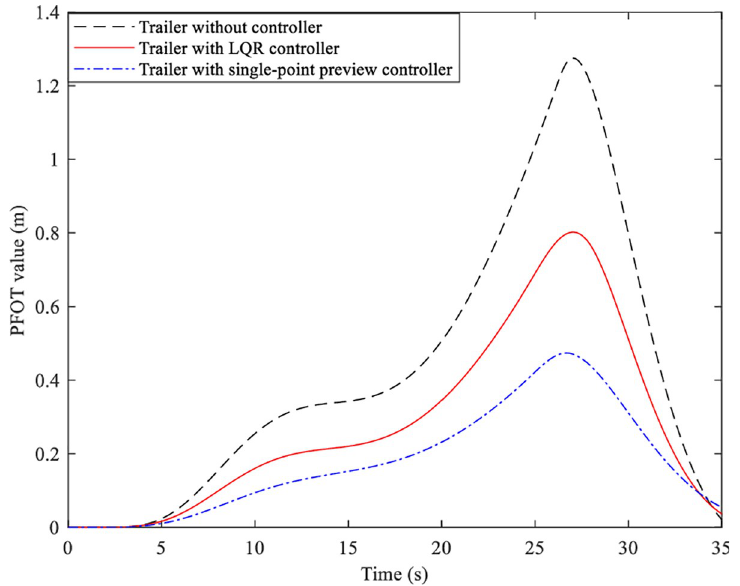
Fig 11. PFOT value of three kinds of